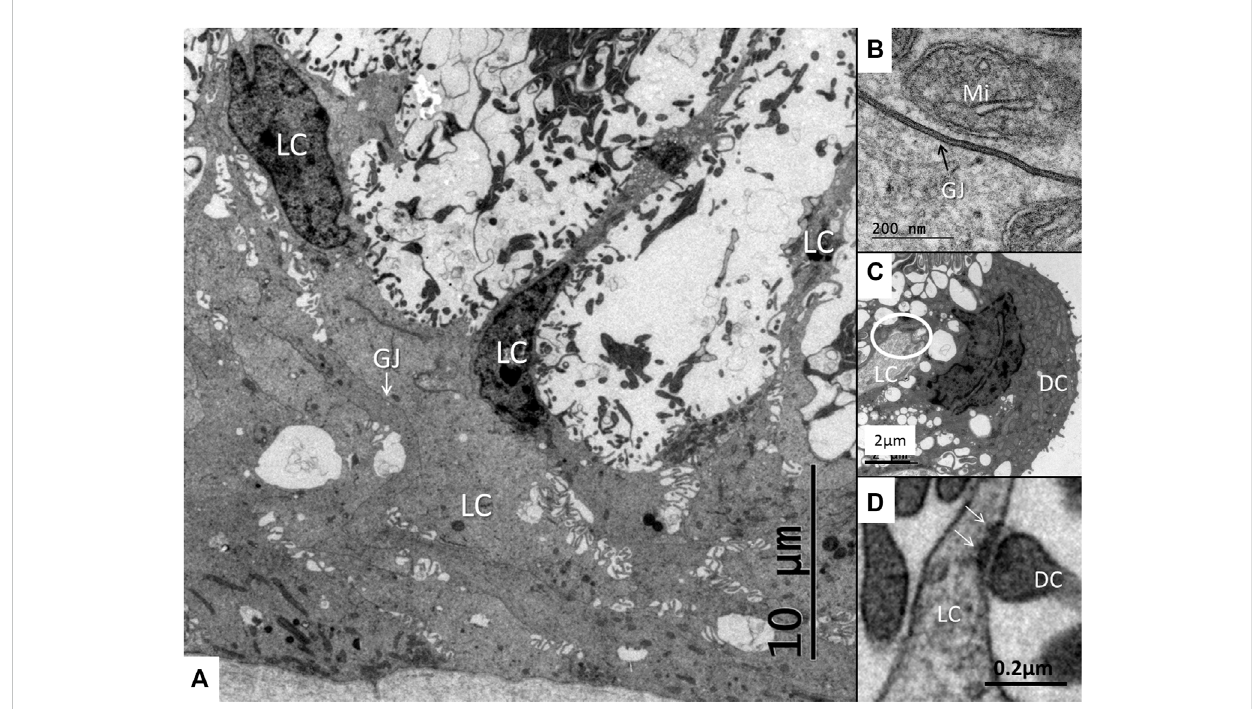
FIGURE 6 (A) Light cells (LC) at the base of the stria vascularis with intercellular spaces containing dark cell enfoldings. The light cells display extensive gap junctions (GJ). (B) Higher magni fi cation shows a gap junction between two light cells. Mi, mitochondrion. (C) Light cell process (LC) forms an occlusion (encircled) against the dark cell (DC). (D) Interaction between the light cell (LC) and dark cell (DC) process within the dilated space. Membrane specialization with focal densities are seen